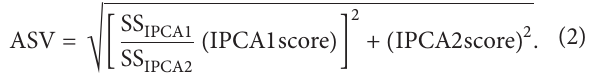
consisted of four rows of sorghum at a spacing of 60 cm by drill and the blocks were separated by 1.5 m path. Triple super- phosphate fertilizer was applied uniformly to all plots at a rate of 17.2 kg per ha before sowing. Control of weeds was done manually using hoes, three weeks after seedling emergence, and sorghum were thinned to a spacing of 10 cm within the row. And then, calcium ammonium nitrate (25% N) was top- dressed at the rate of 20 kg N/ha. Birds guarding was effected soon after the panicles formed to prevent grains damage.